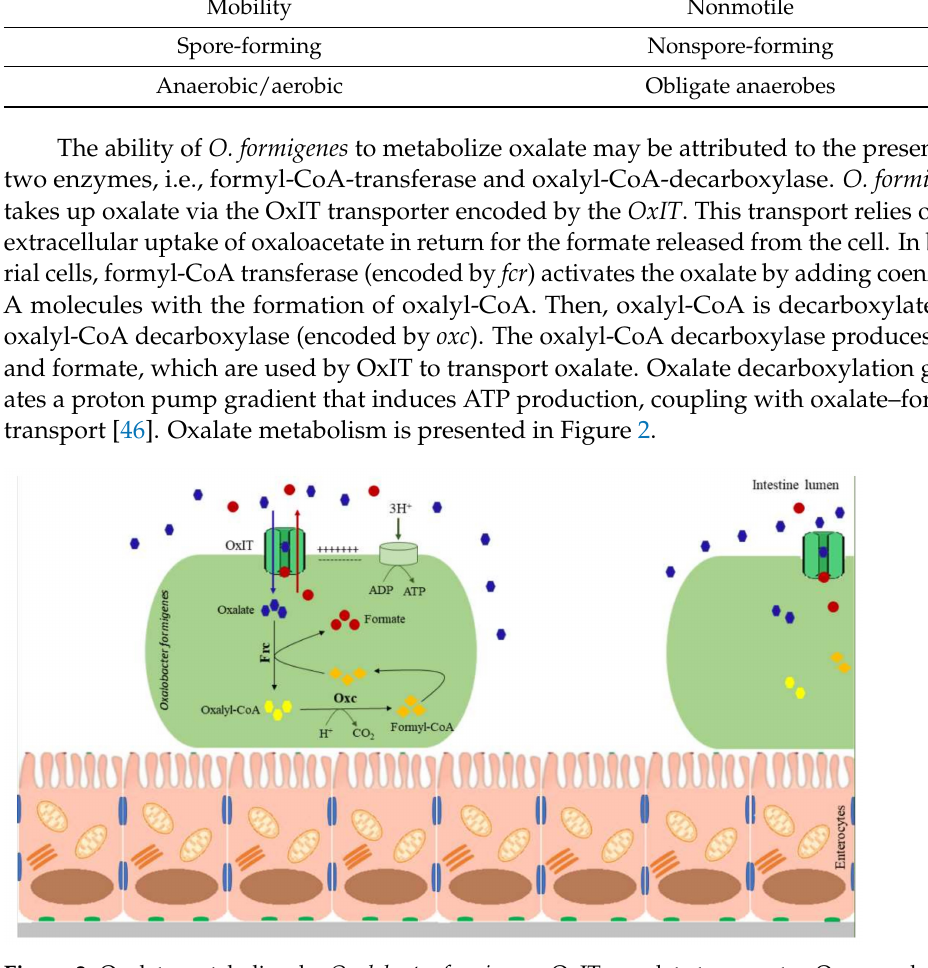
Figure 2. Oxalate metabolism by Oxalobacter formigenes. OxIT—oxalate transporter, Oxc—oxalyl-CoA decarboxylase, Frc—formyl-CoA